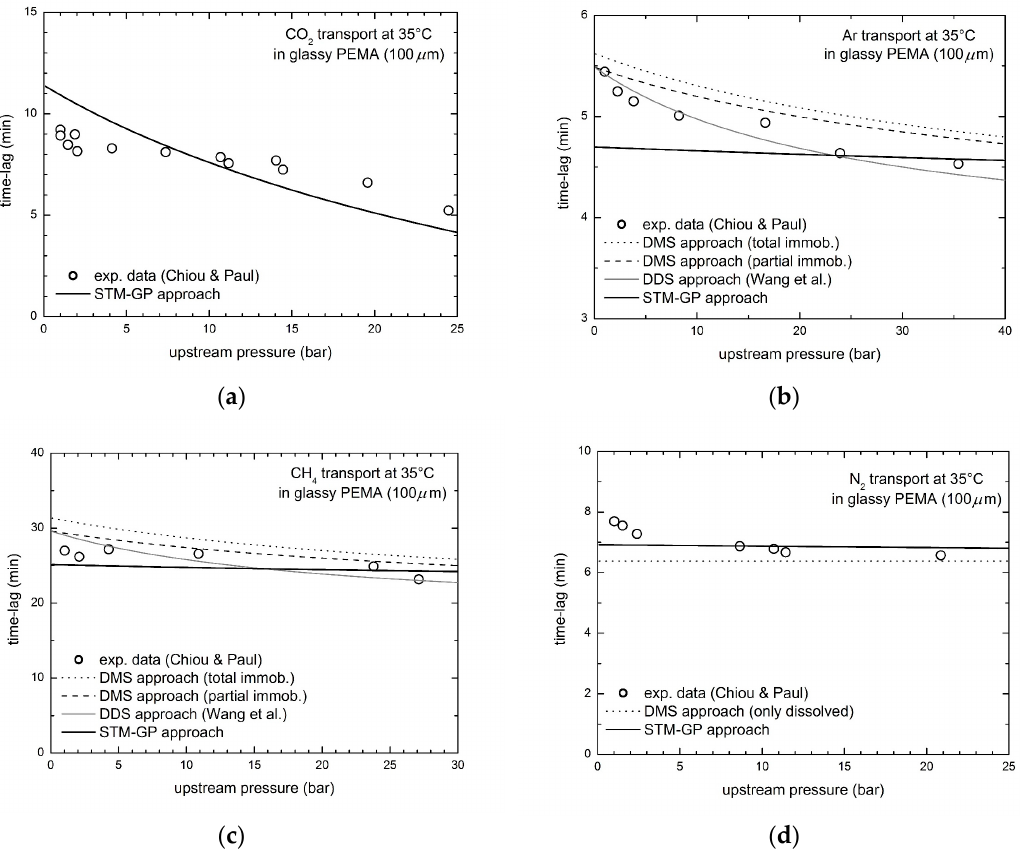
Figure 6. Diffusional time lag for gas transport in glassy PEMA at 35 °C, experimental data by Chiou and Paul [53] and STM-GP model predictions: ( a ) CO 2 ; ( b ) Ar; ( c ) CH 4 ; and ( d ) N 2 .